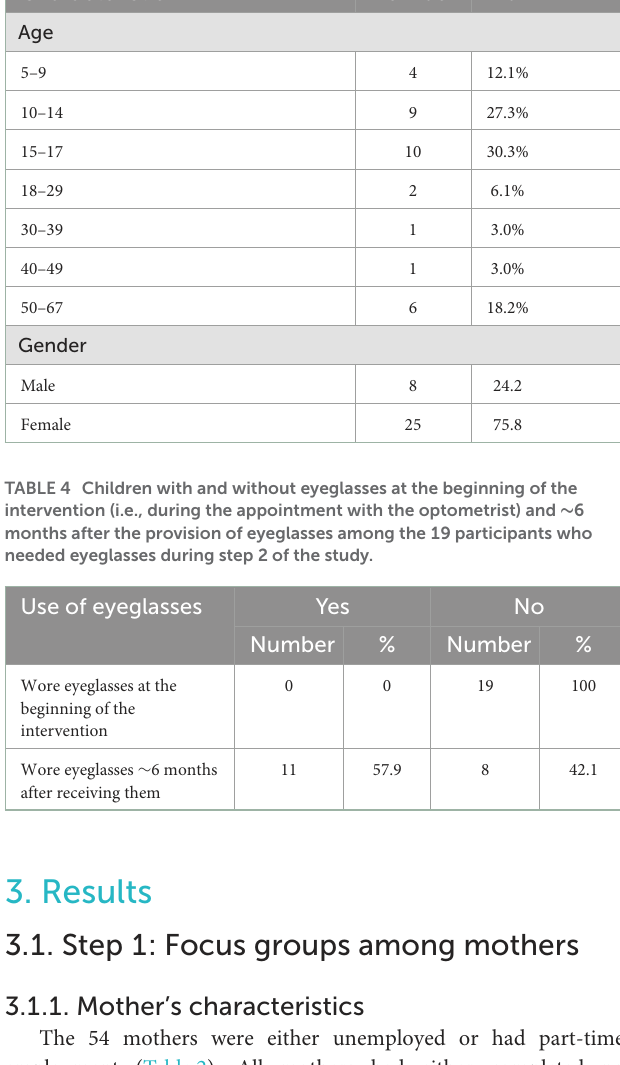
TABLE 3 Age and gender of the 33 participants whose eyes were examined by the optometrist during step 2 of the study. Characteristic